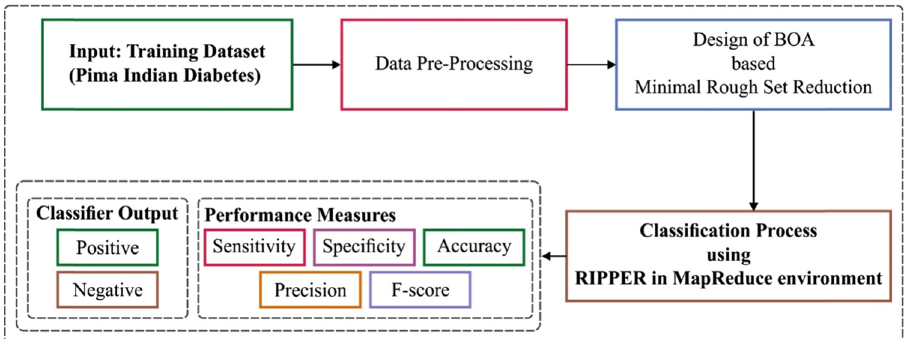
Figure 1: Overall process of MRSFS - RMDC